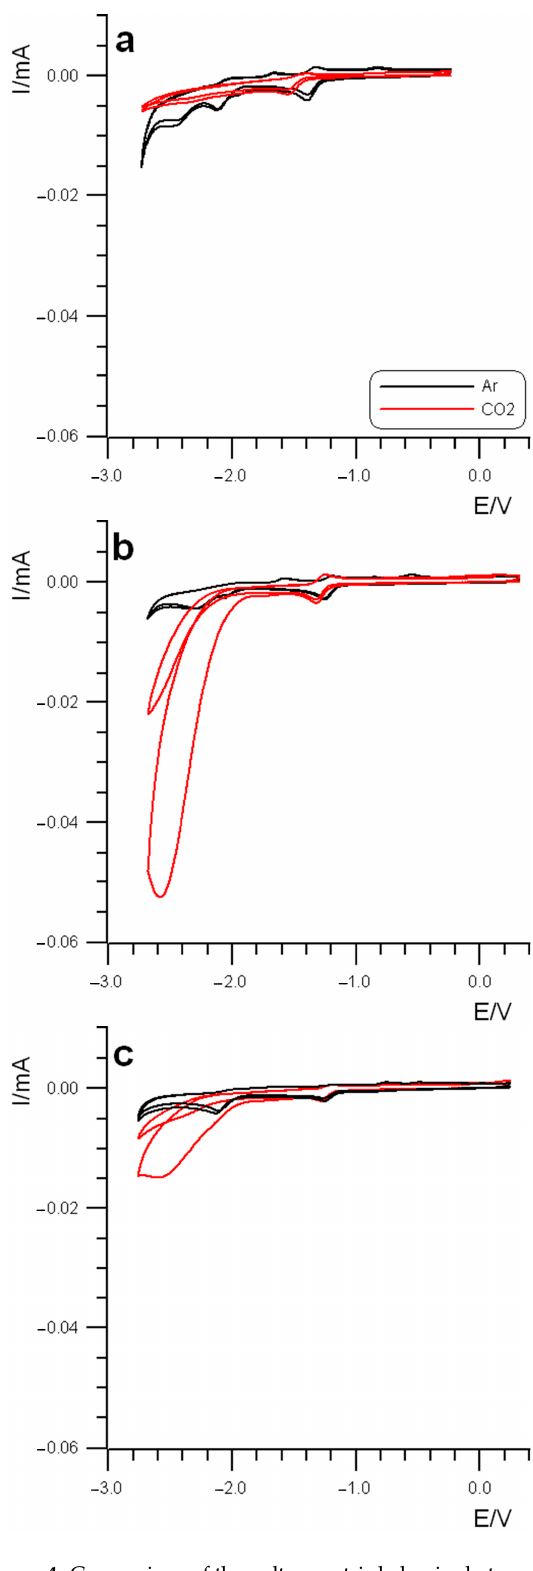
Figure 4. Comparison of the voltammetric behavior between Mn-OMe 0.6 mM ( a ), Mn-SMe 0.9 mM ( b ), and Mn-SPh 0.3 mM ( c ) in the TBAH/ACN electrolyte solution in the presence of Ar (black traces) and CO 2 (red traces). Working electrode: GC disk (7.85×10 − 3 cm 2 ); reference electrode: SCE; scan rate ( υ ): 0.4 V/s; T= 298 K.